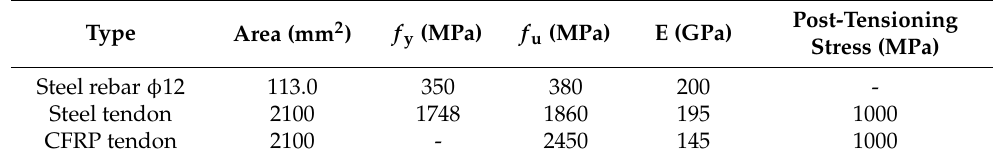
Table 2. Material properties of Beam-1 and